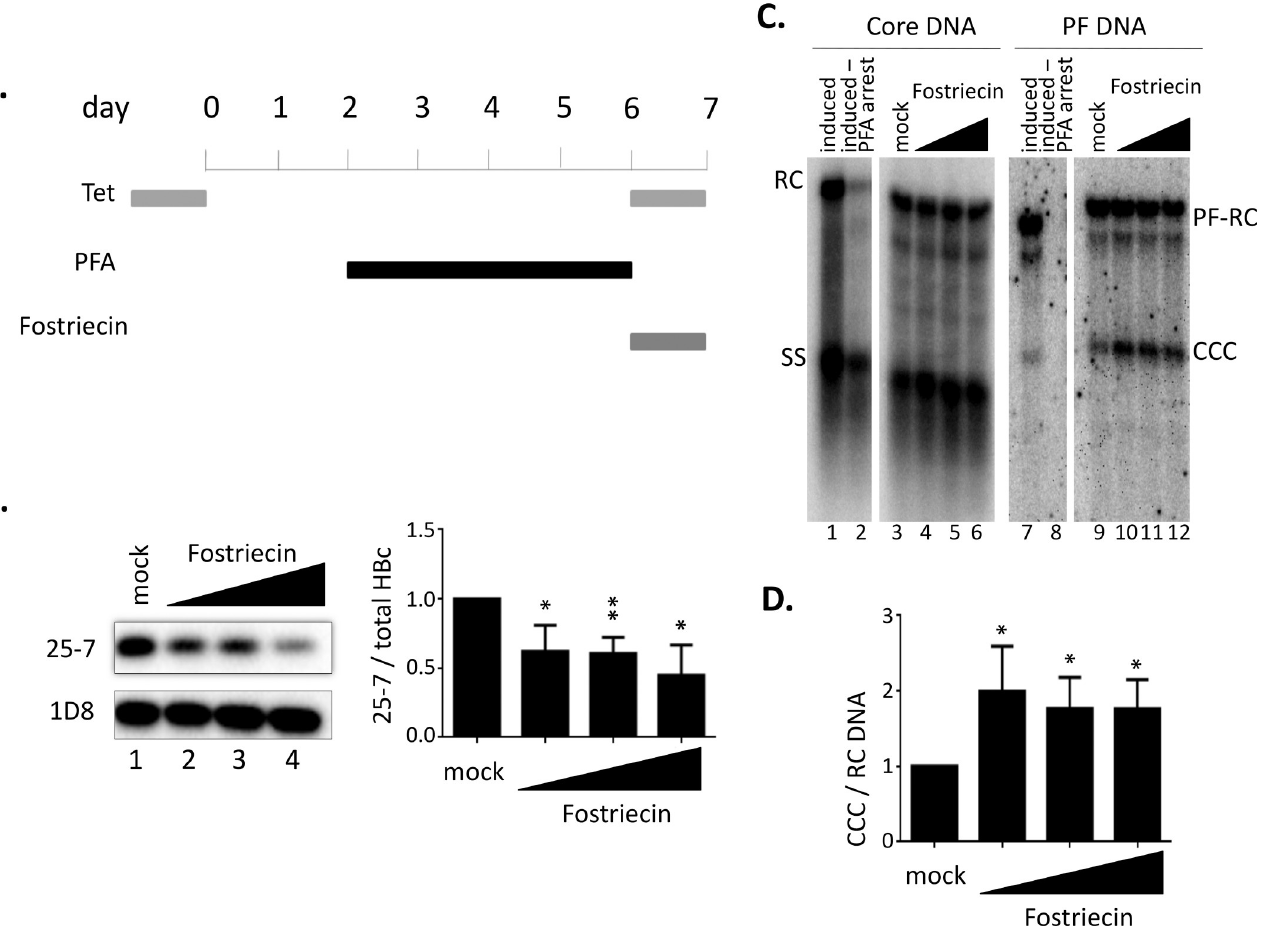
Fig 11. Effect of PP2A inhibition on HBc dephosphorylation and viral DNA replication in cell culture. A. Scheme for rapid and synchronized NC maturation and CCC DNA formation in cell culture. Following removal of tetracyclin (tet) from HepAD38 cells for two days to induce pgRNA expression packaging, PFA was added to arrest HBV DNA synthesis at the single-stranded (SS) DNA stage. Following 4 days of PFA treatment to accumulate SS DNA NCs, PFA was removed to allow rapid and synchronized synthesis of RC DNA from SS DNA and RC DNA conversion to CCC DNA during the ensuing one day before the cells were harvested. At the same time of PFA removal, tetracyclin was added back to turn off pgRNA synthesis and thus suppress further production of immature NCs. Fostriecin (20 μ M, 40 μ M, 60 μ M) was added at the same time when PFA was removed. The cells were then harvested for analysis of HBc dephosphorylation ( B ) and viral DNA synthesis ( C ). B. HBc was resolved by SDS-PAGE and detected by western blot analysis, using the HBc CTD dephosphorylation (S178) specific mAb (25–7) or NTD mAb (1D8, for total HBc). The dephosphorylated HBc signal was normalized to total HBc signal. The normalized dephosphorylation signal of HBc treated with Fostriecin is shown in the graph relative to that of mock treatment, which was set to 1.00. C. HBV NC-associated DNA (core DNA, lane 1–6) and PF DNA (lane 7–12) were detected by Southern blot analysis. Lane 1 and 7 (induced): DNA from control cells cultured in the absence of tetracyclin or PFA for 7 days; lane 2 and 8 (induced-PFA arrest): DNA from cells harvested right at the end of PFA treatment before PFA release. RC, RC DNA; SS, SS DNA; PF-RC, PF-RC DNA; CCC, CCC DNA. D. Quantitative results of CCC DNA normalized to core RC DNA. The normalized CCC DNA signals from the cells treated with Fostriecin is shown relative to that of the mock treatment, which was set to 1.00. � , P < 0.05; �� , P < 0.01.